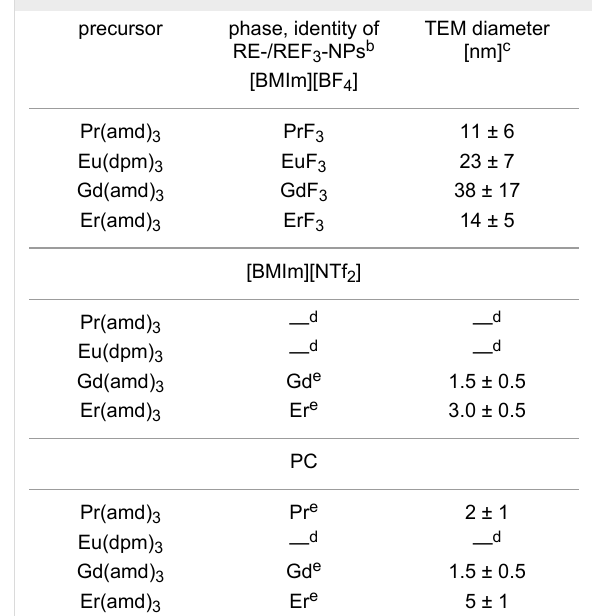
Table 1: RE-/REF 3 -NPs sizes and size distributions.